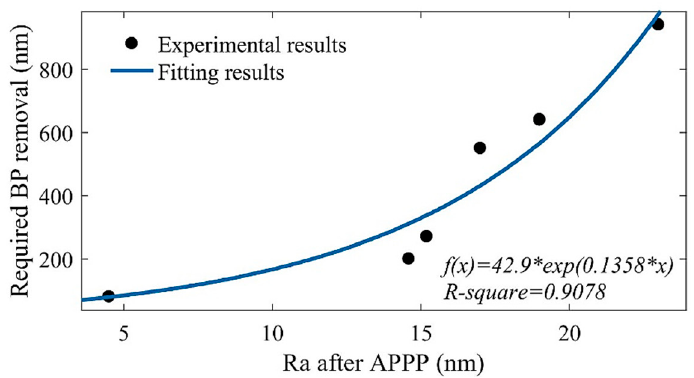
Figure 11. The required BP removal to smooth the etched texture versus the R a after APPP.